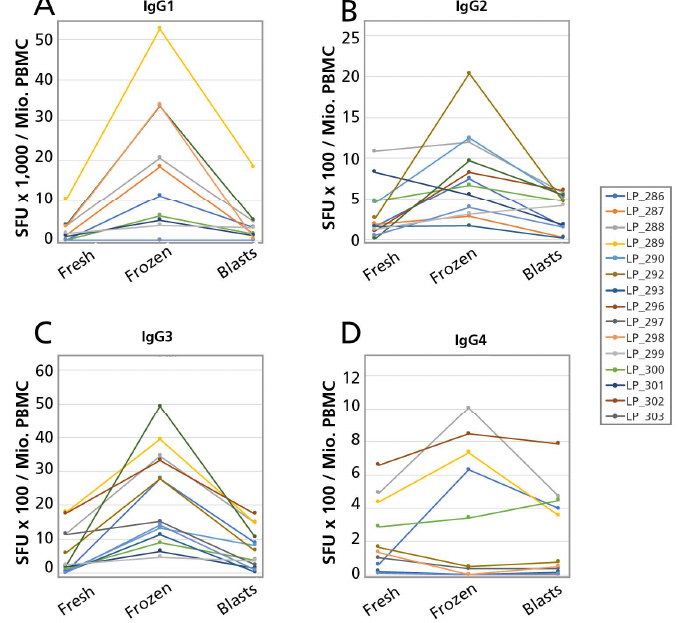
Figure 6. Effect of cryopreservation on IgG subclass production by B cells. The legend to Figure 5